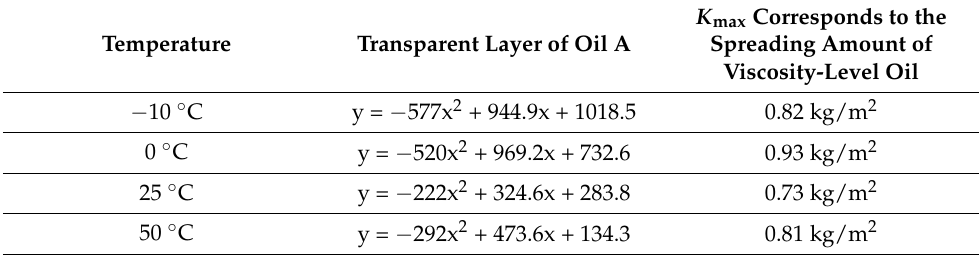
K max Corresponds to the Spreading Amount of Viscosity-Level Oil